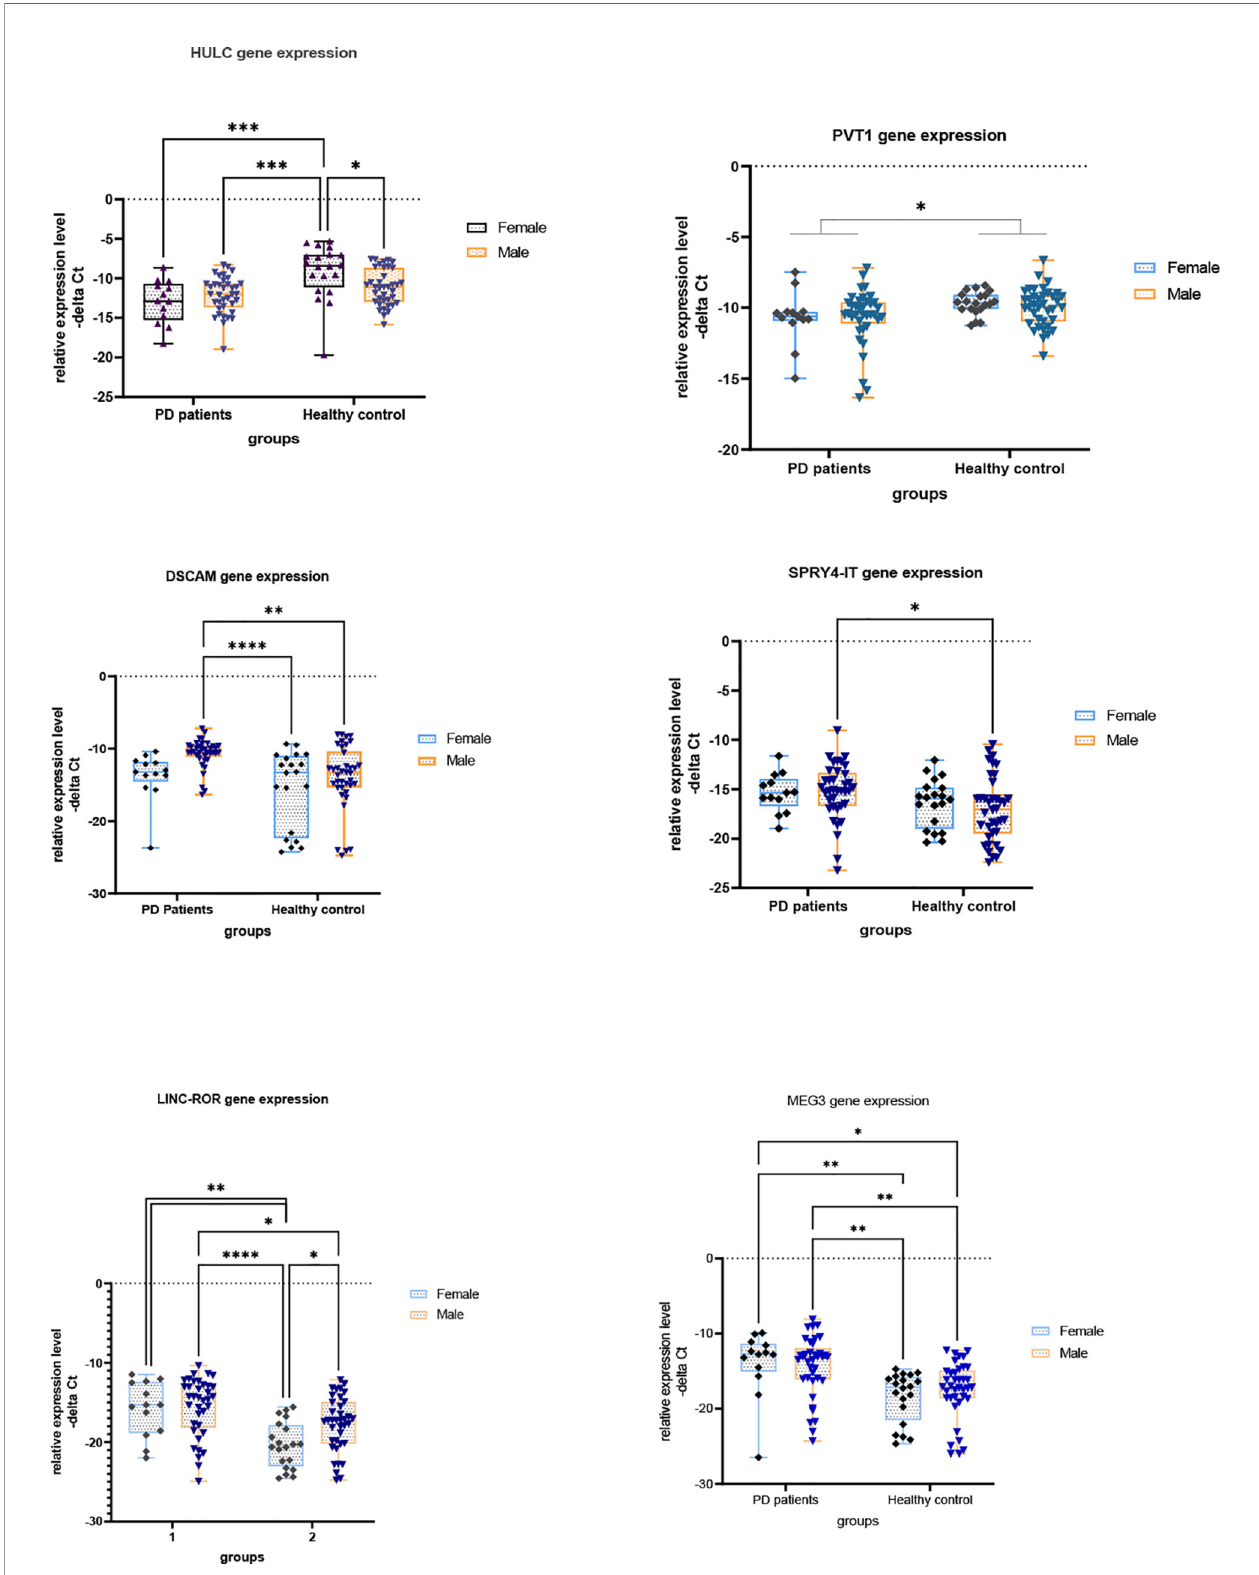
FIGURE 1 | Relative expression levels of lncRNAs in PD patients versus controls (*P value < 0.05, **P value < 0.001, ***P < 0.001 and ****P value <